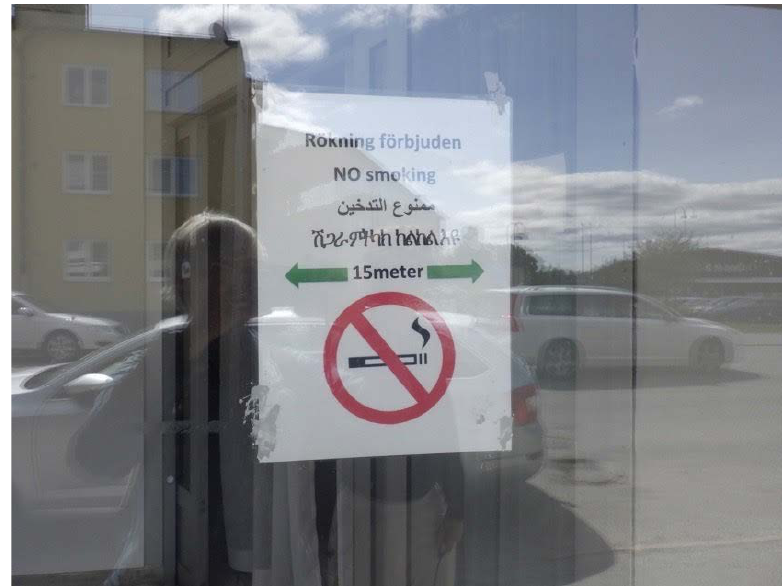
Figure 7. Information Paper in Window .